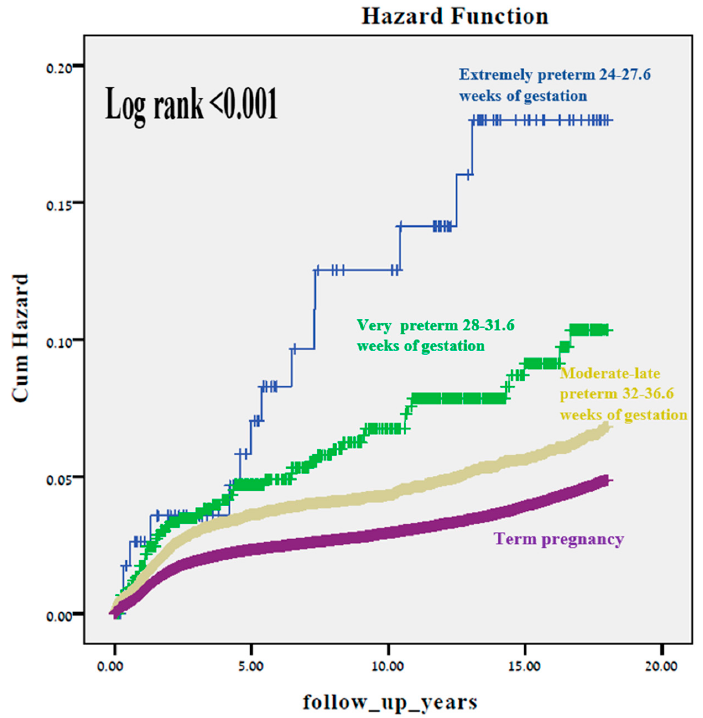
Figure 1. A Kaplan–Meier survival curve exhibiting the cumulative incidence of long-term neurologic-related hospitalizations according to gestational age (Log-Rank test p < 0.001).